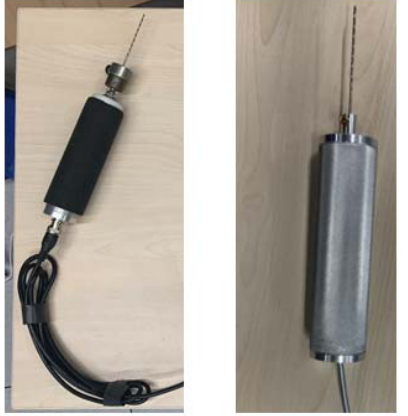
Figure 1. Acquisition equipment